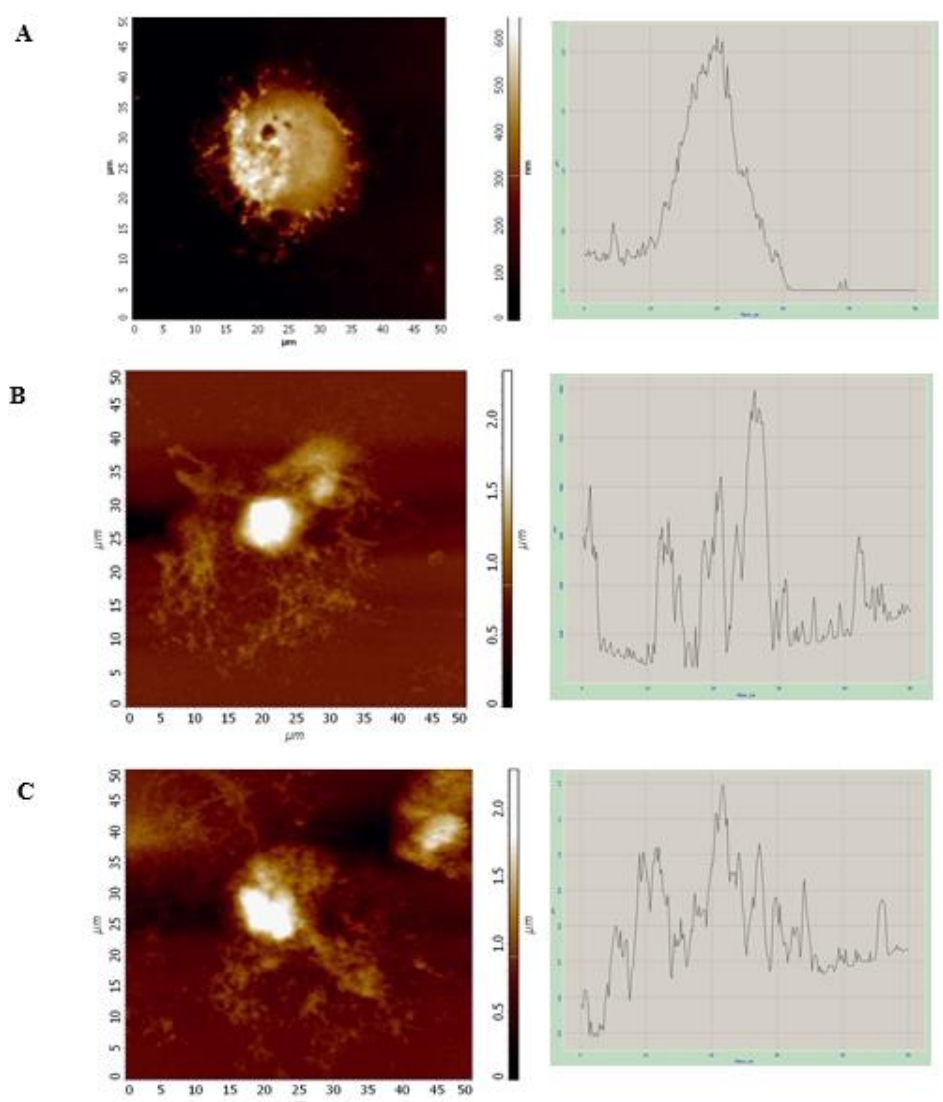
Figure 2. Atomic force microscopy (AFM) surface topography and line profile analysis of ( A ) untreated Caco-2 cells; ( B ) Caco-2 cells treated with 72 h UV-radiated fish oil (100 µ g / mL) for 24 h; ( C ) Caco-2 cells incubated with 72 h UV-radiated ML (100 µ g / mL) for 24